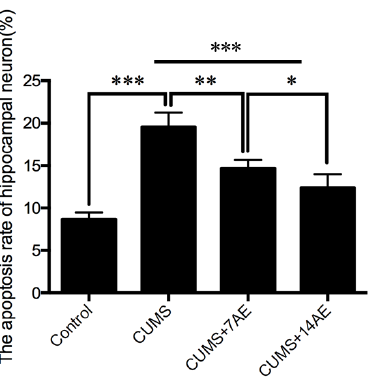
Figure 3. Effects of aerobic exercise on CUMS-induced hippocampal neuronal apoptosis. * p < 0.05; ** p < 0.01; *** p < 0.001; CUMS: chronic unpredictable mild stress; 7AE: Aerobic exercise for 7 days; 14AE: Aerobic exercise for 14 days.